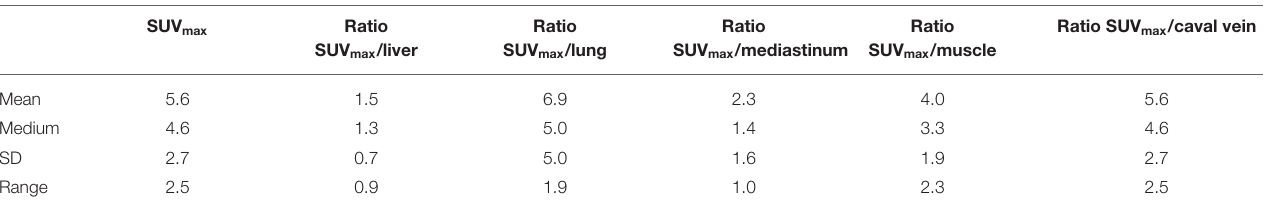
Ratio Ratio Ratio Ratio SUV max /caval vein SUV max /lung SUV max /mediastinum SUV max /muscle